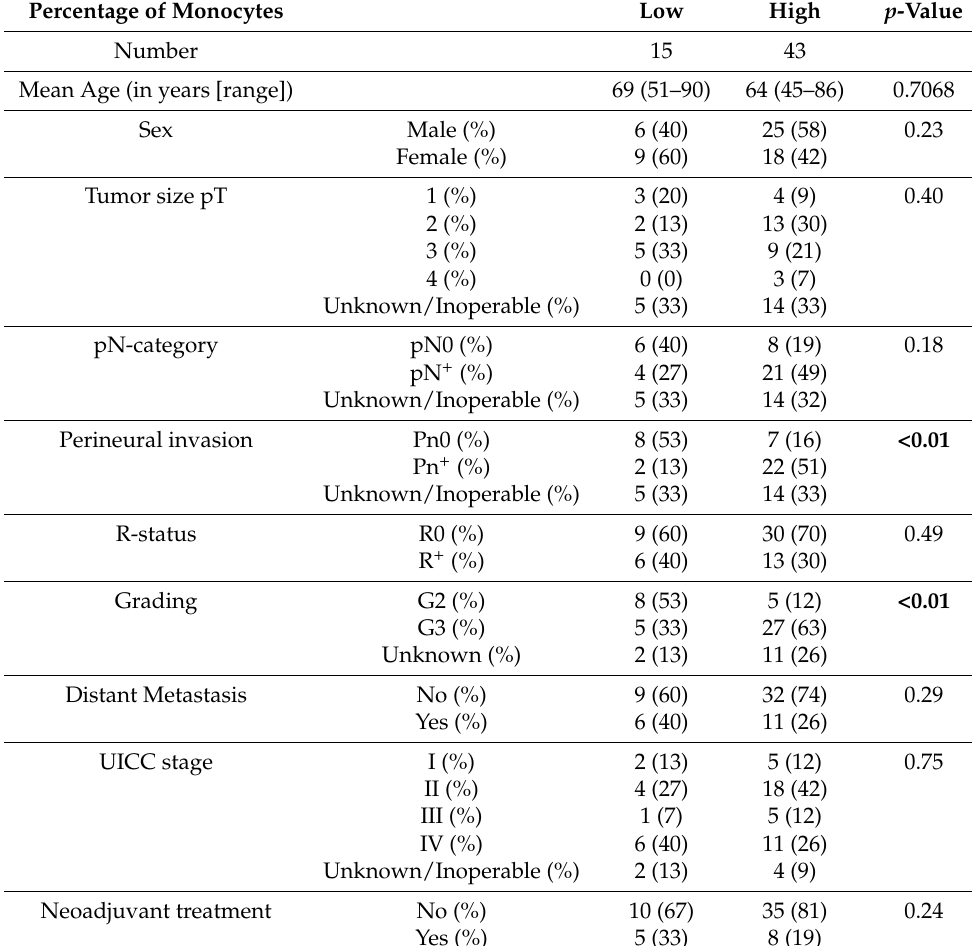
Table 3. Clinico-pathological parameters of the PDAC study cohort stratified by the percentage of monocytes in low ( n = 15; ≤ 5%) and high ( n = 43;